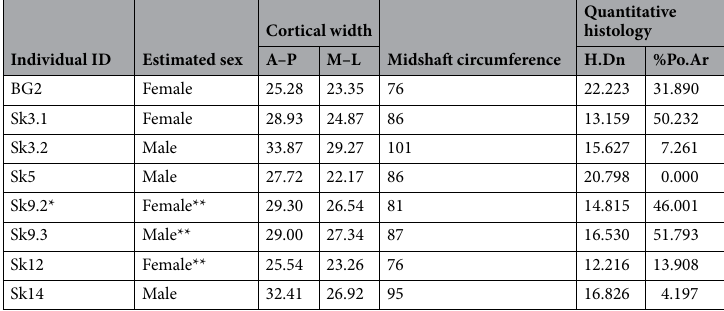
Table 1. Sample details and raw gross morphometric data of the femora representing adult archaeological males and females from Talasiu, Tongatapu, Kingdom of Tonga. Cortical width and midshaft circumference are reported in mm. A-P: antero-posterior, M-L: medio-lateral, H.Dn: Haversian canal density per mm 2 , %Po.Ar: percent of sample impacted by porosity producing trabecularisation. *left femur, **probable